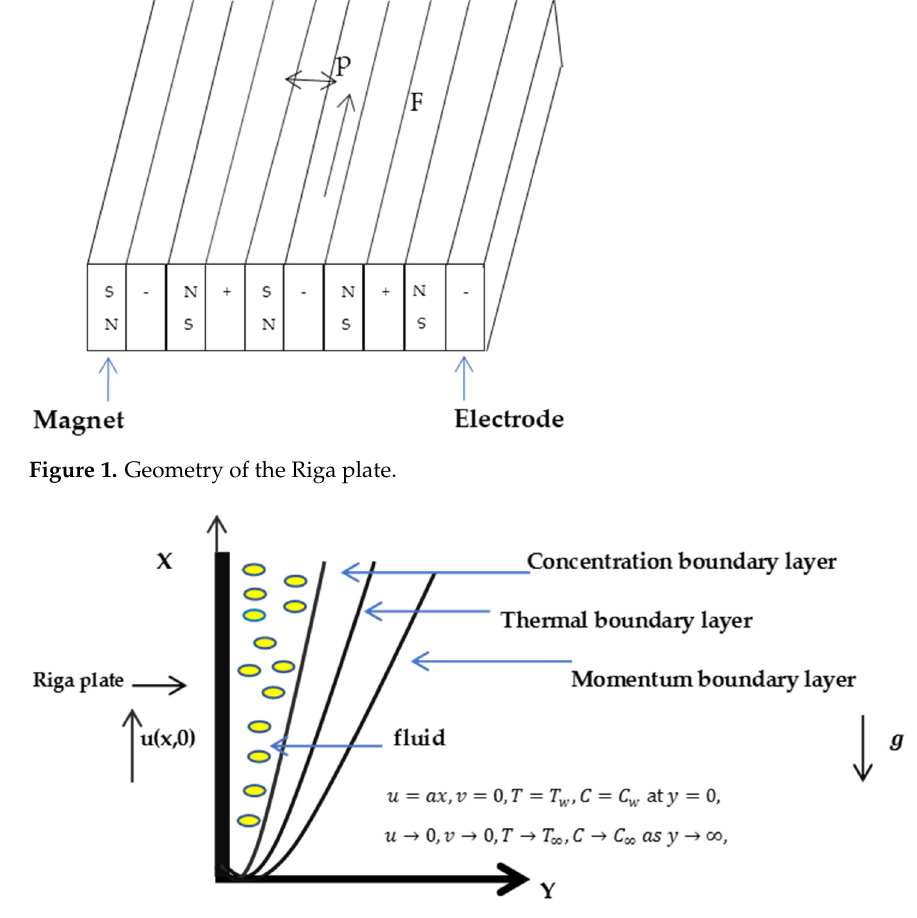
Figure 2. Schematic diagram of the problem.